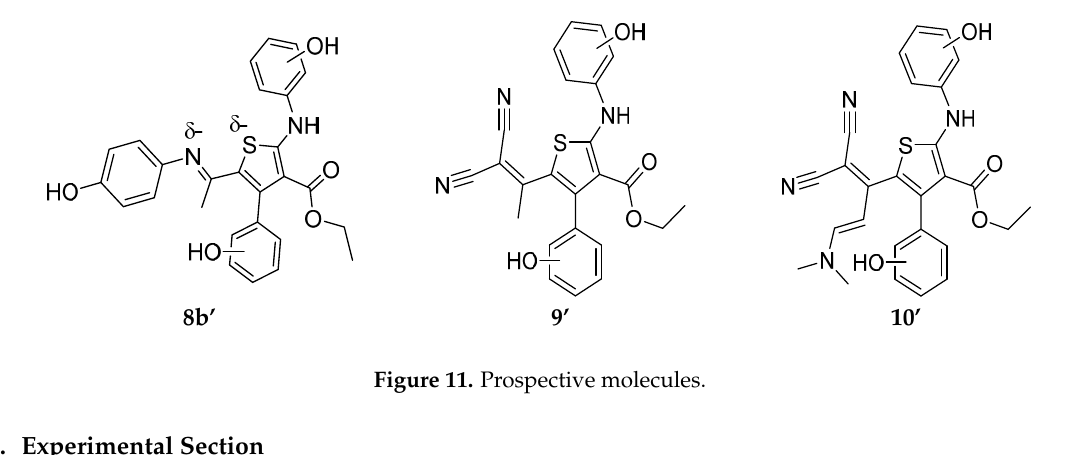
Figure 11. Prospective molecules.